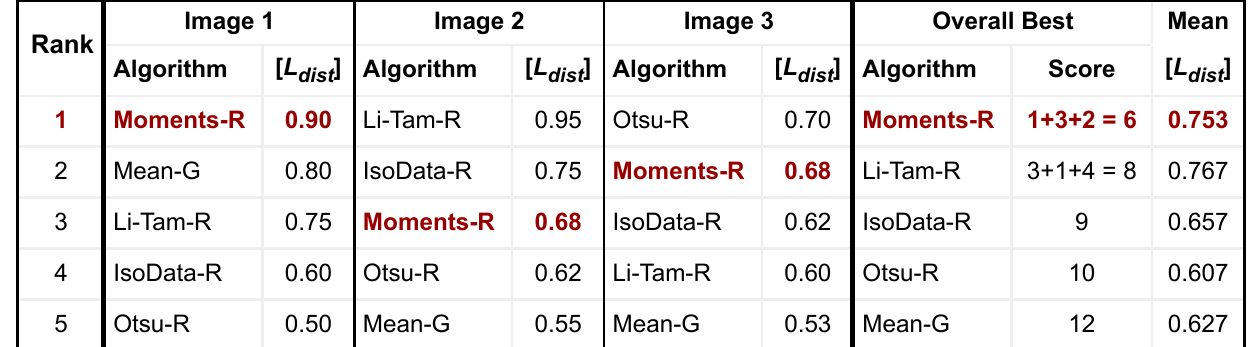
Figure 4. Example of sorting by the ranking summation criterion. The algorithm marked in red (Moments-R) is the overall best according to this